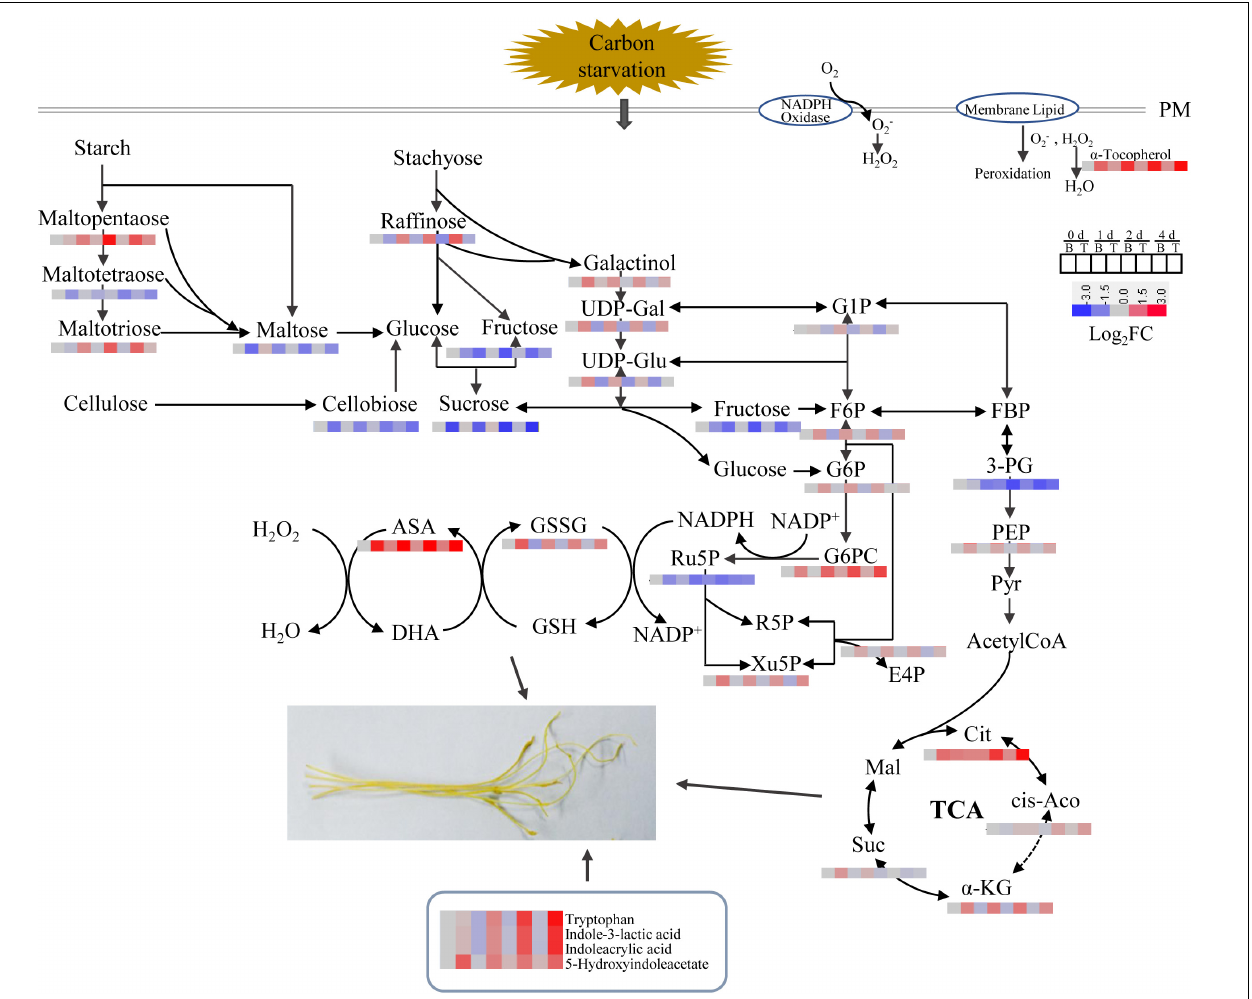
FIGURE 7 | Dynamics of metabolic pathways throughout the in vitro dodder shoots development process. The metabolite amounts were shown in heatmaps. PM (plasma membrane), UDP-Gal (UDP-D-galactose), UDP-Glu (UDP-D-glucose), G1P (glucose 1-phosphate), F6P (fructose 6 phosphate), G6P (glucose 6-phosphate), FBP (fructose 1,6 bisphosphate), 3-PG (glycerate-3-phosphate), PEP (phosphoenolpyruvate), Cit (citrate), cis -Aco ( cis -aconitate), α -KG ( α -ketoglutarate), Suc (succinate), Mal (malate), G6PC (6-phosphogluconate), E4P (erythose 4-phosphate), R5P (ribose 5-phosphate), Xu5P (xylulose 5-phosphate), GSSG (oxidized glutathione), GSH (reduced glutathione), ASA (ascorbate), and DHA